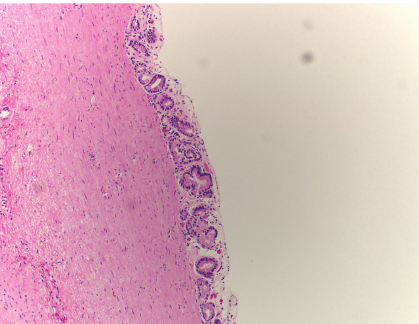
Figure 5: Histological H&E stain. Cystic lesion from the gastric cardia showing benign developmental cyst lined by mucinous columnarandrespiratoryepitheliumwithsmoothmuscleinthecyst wall. 100x